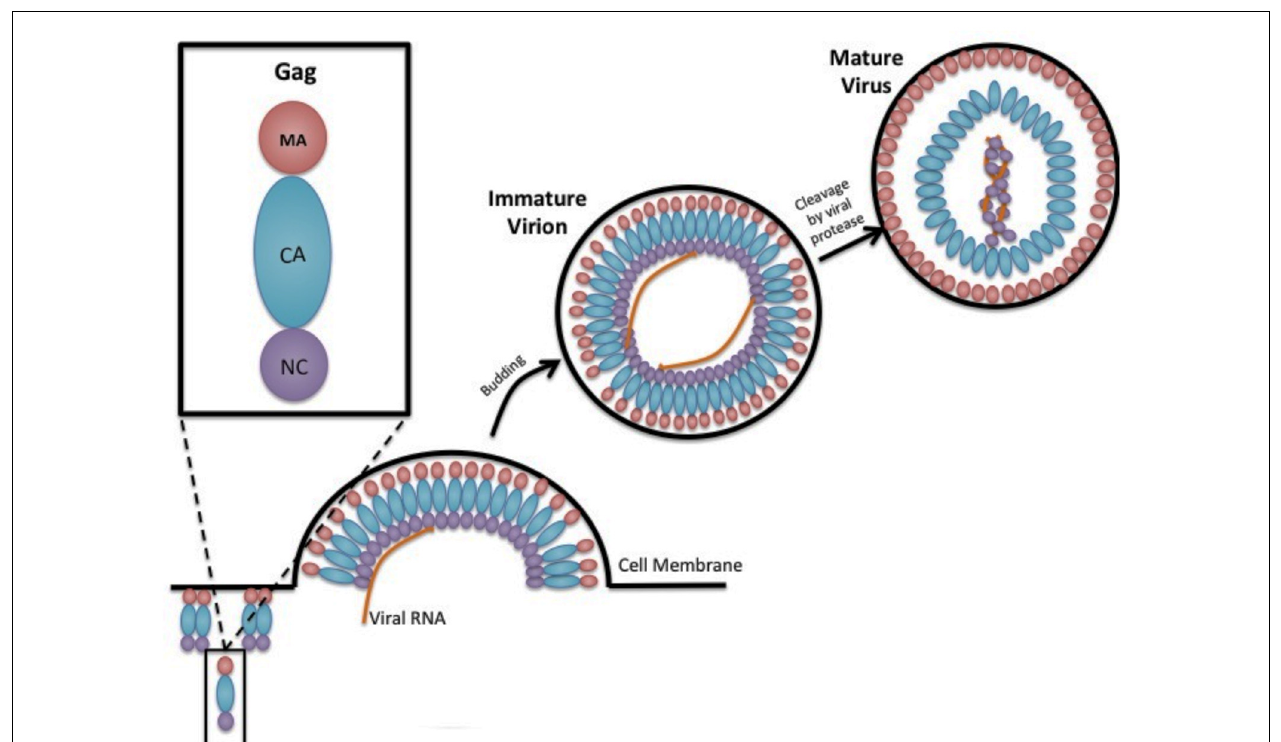
mature infectious virus particle that is catalyzed by the viral-encoded protease. Gag is shown as being composed of the matrix domain (red circle), the capsid domain (blue oval), and the nucleocapsid domain (purple circle). Two copies of the viral RNA (two orange lines inside the viral particle) are shown packaged into the virus